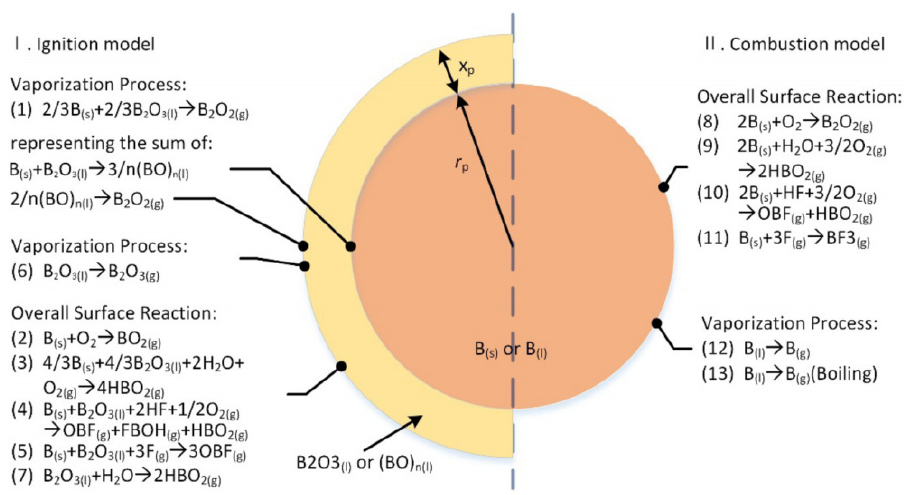
Figure 1. The ignition and combustion model of boron particles [11]. Reprinted with permission from Ref. [11] Fuel Processing Technology